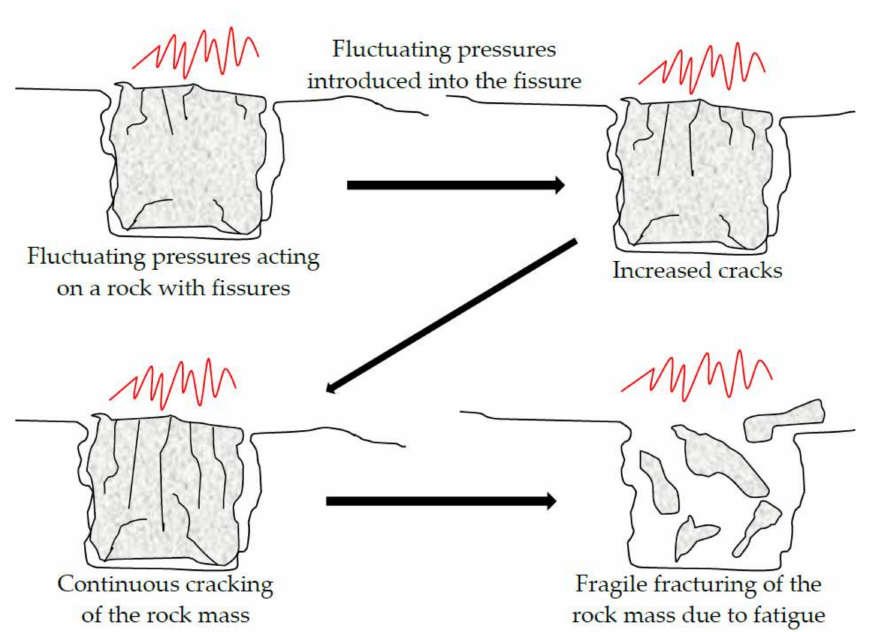
Figure 3. Erosion by the continuous fragile fracturing of a rock mass or hydrofracturing by fatigue